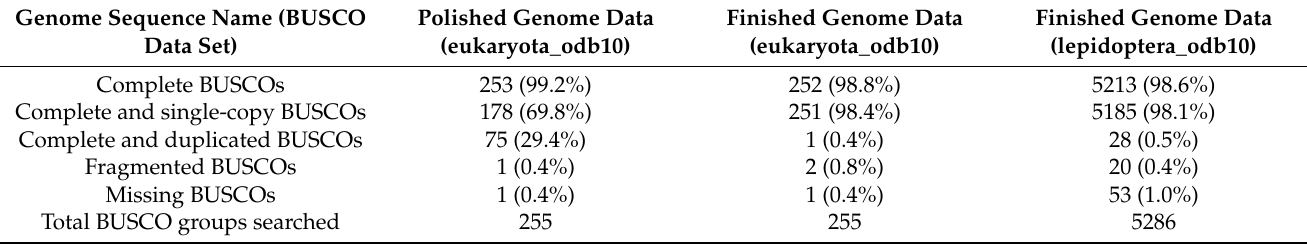
Table 2. The results of BUSCO using the constructed genome sequence